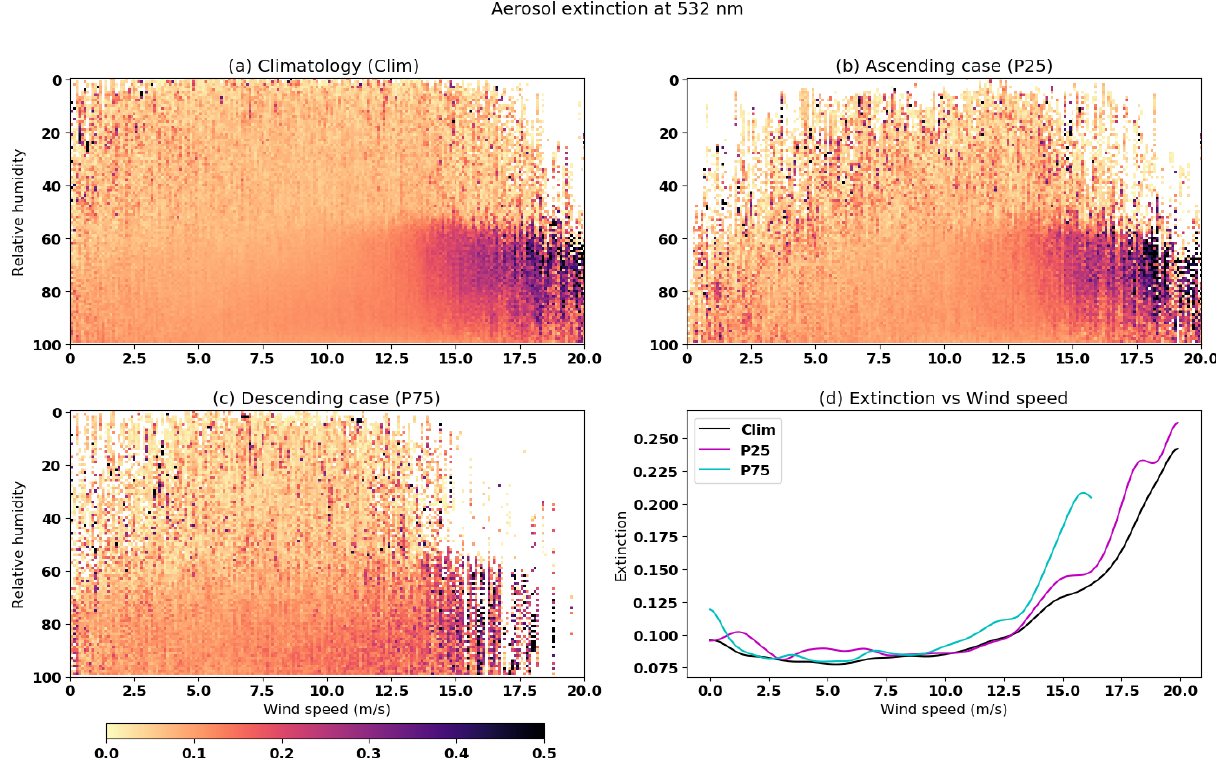
Figure 2. The same as in Fig. 1 but for the extinction coefficient (km − 1 ) at